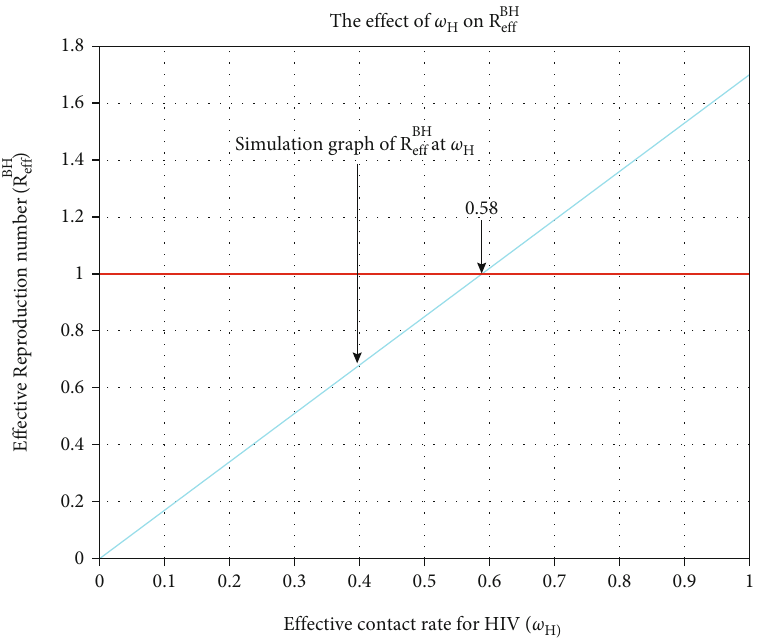
Figure 16: Simulation of the reproduction number of HBV-HIV/AIDS coinfection at variable contact rate for HIV transmission ω